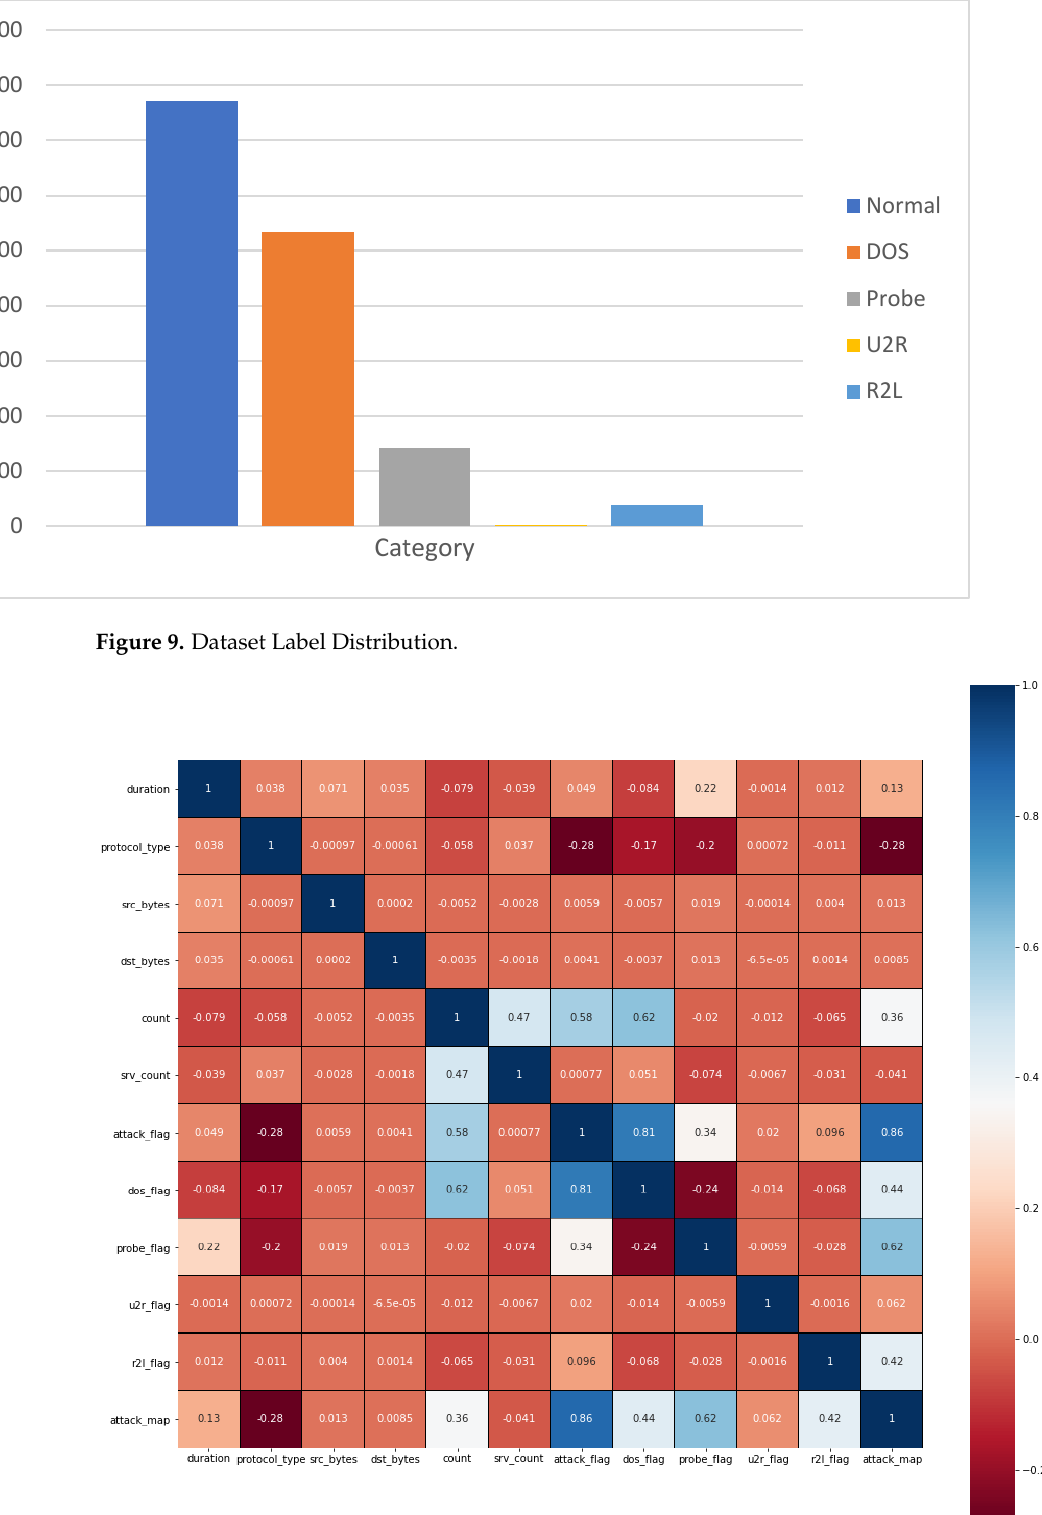
Figure 10. Heatmap illustrating feature importance and correlation.